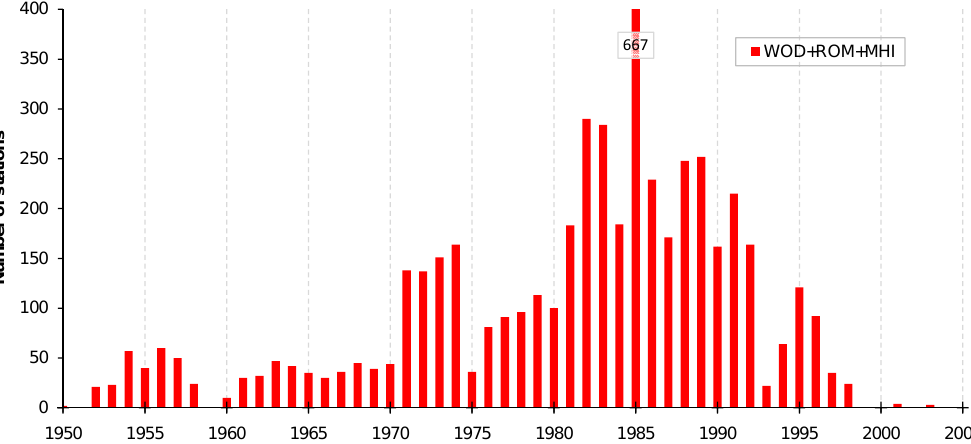
Fig. 8. Number of stations in the shelf compartment for which BSW temperature anomalies during May–November could be calculated from the combined WOD+ROM+MHI